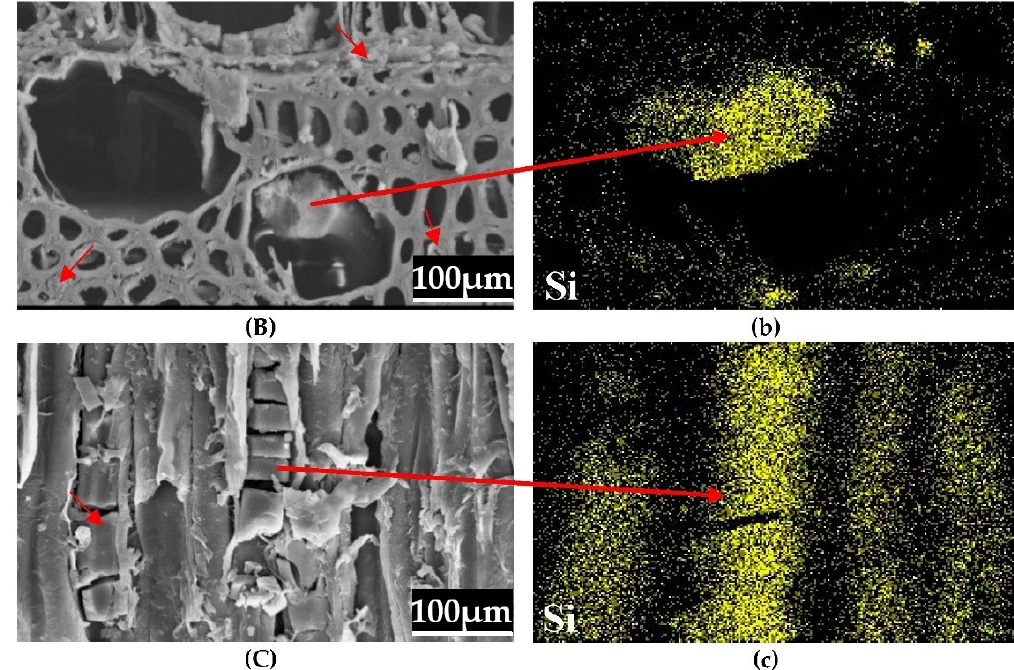
Figure 4. SEM-EDX image of the modified wood ( A —cross section the untreated wood; B —cross section of G 20 S 10 treated wood; C —longitudinal section of G 20 S 10 treated wood; a , b , c —are the scanning distribution diagrams of silicon in A , B , and C , respectively).